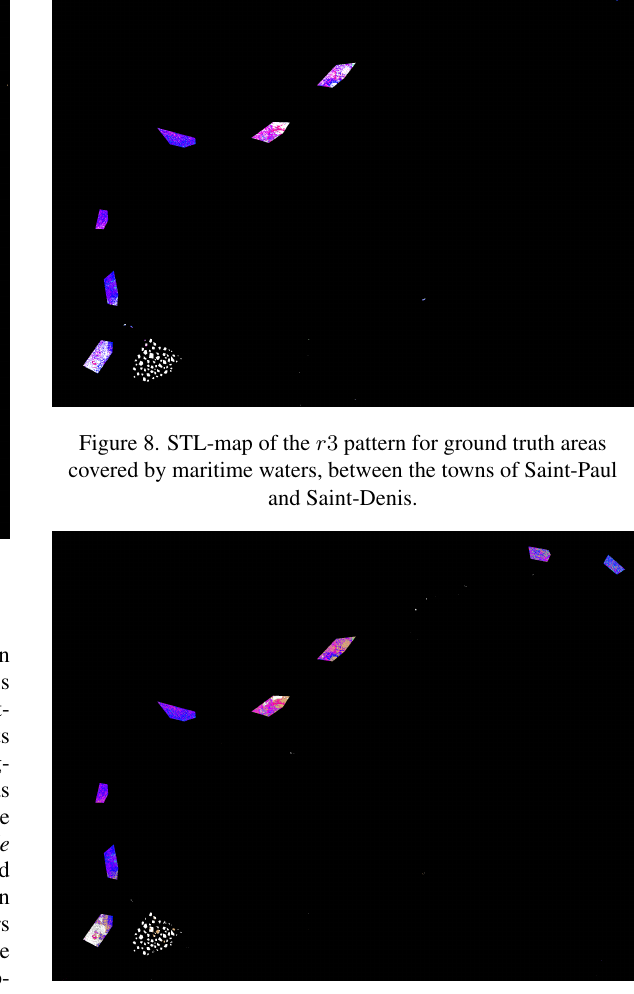
Figure 9. STL-map of the r 3 pattern for areas identified as waters by the DSLCC, between the towns of Saint-Paul and